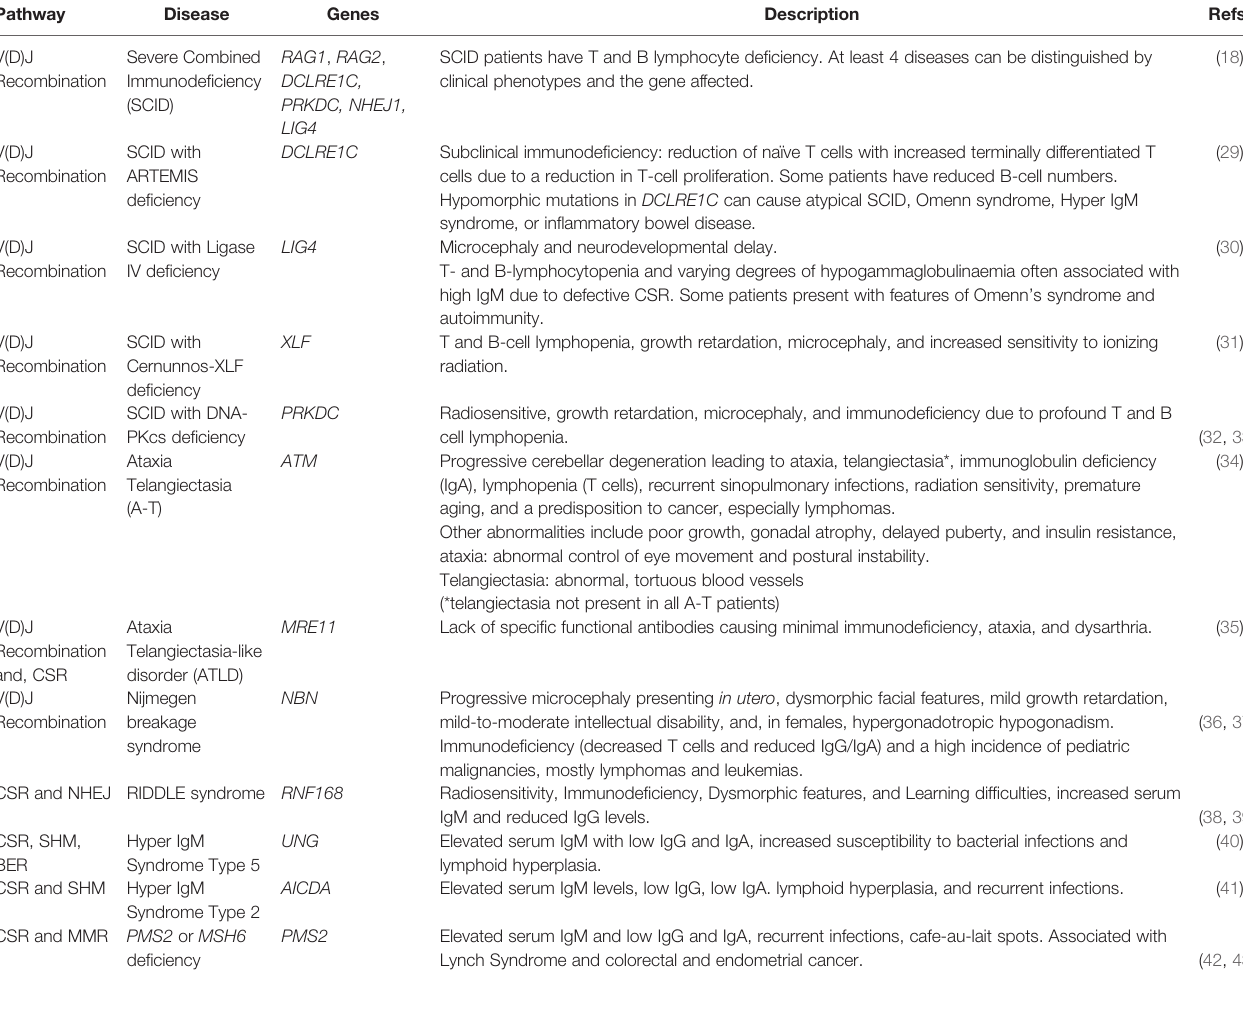
TABLE 1 | DNA repair de fi ciency-induced immunological disorders. Pathway